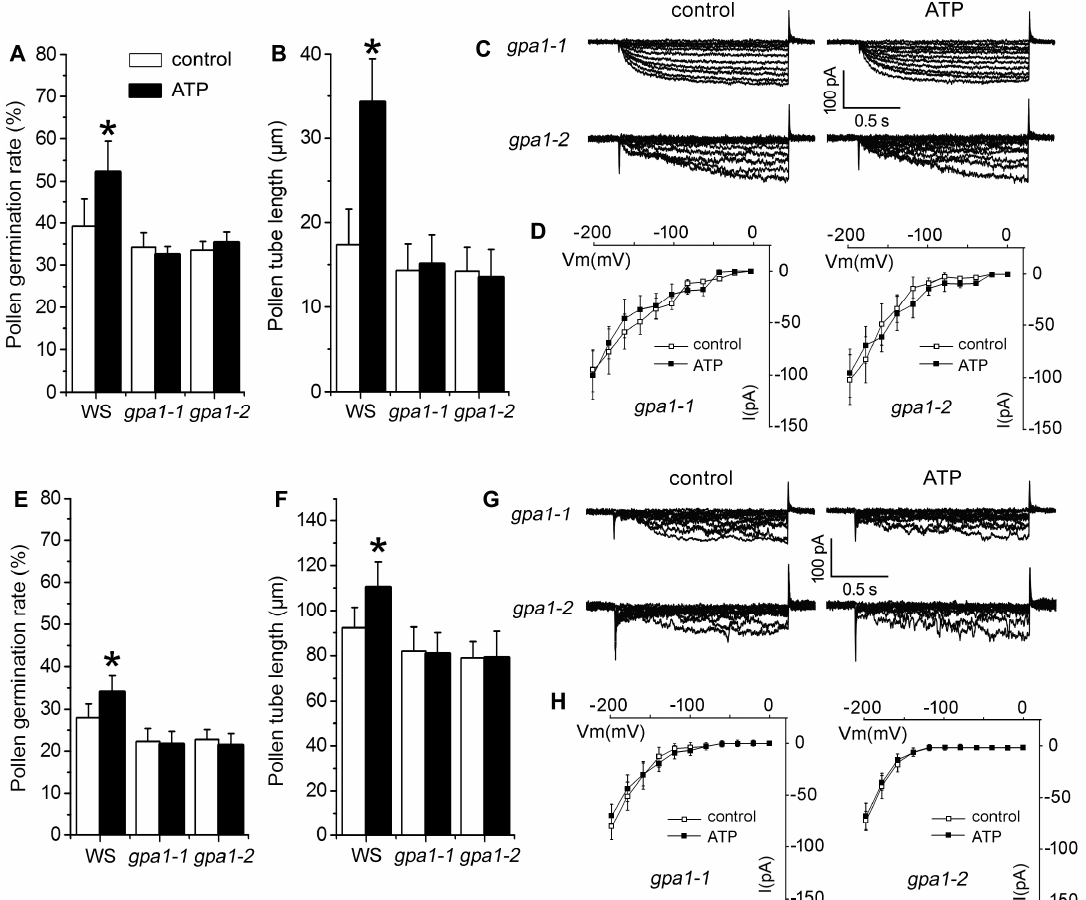
Figure 7. Heterotrimeric G protein α subunit (GPA1) is involved in eATP-regulated PG, PTG, and ion influx. Two GPA1 null mutants ( gpa1-1 , gpa1-2 ) were used. ( A – D ) show the effects of ATP on PG ( A ) and PTG ( B ) in medium containing 0.1 mM KCl with corresponding K + influx current traces ( C ) and I-V relationship curves (( D ), n = 7). E–H show the effects of ATP on PG ( E ) and PTG ( F ) in medium containing 0.1 mM CaCl 2 with corresponding Ca 2+ influx current traces ( G ) and I-V relationship curves (( H ), n = 7). In the pollen germination experiment, at least 300 pollen grains or 150 pollen were counted or measured; data from 3 replicates were combined to obtain the mean ± SD. Student’s t test p values: * p < 0.05. In the patch clamp experiment, data from at least 7 pollen protoplasts were recorded and combined to obtain the mean ± SD.